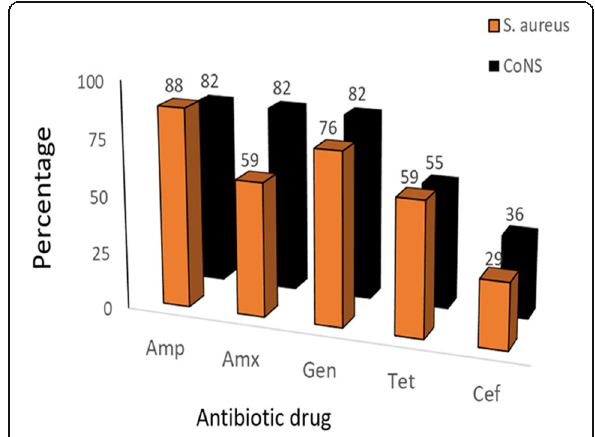
Fig. 5 Percentage resistance of staphylococcal isolates from raw milk to five